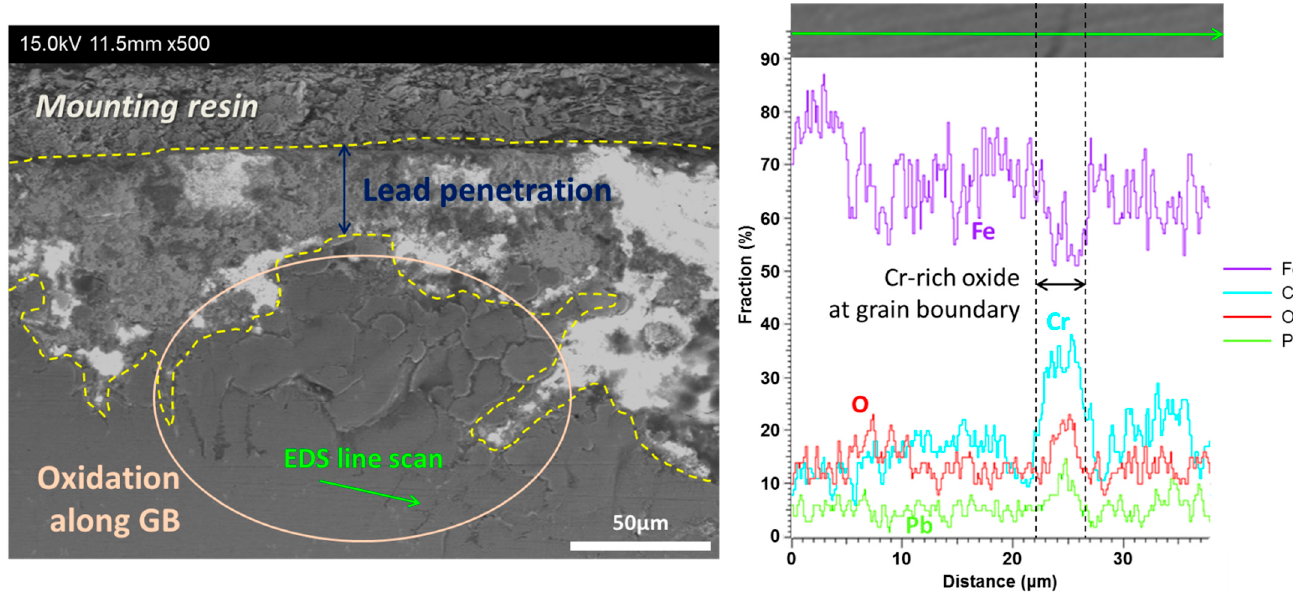
Figure 9. EDS analysis of the HT9 metal substrate close to the severely LBE-penetrated region after 2000 h at 600 °C.